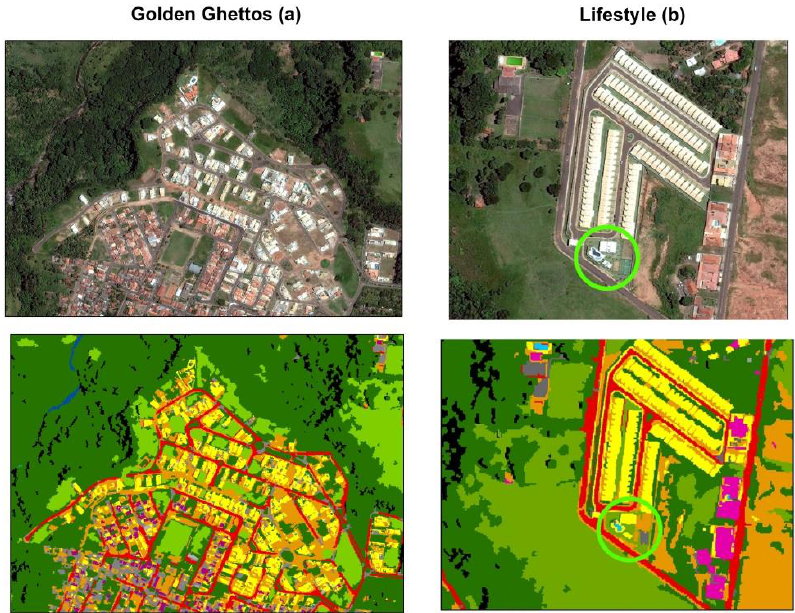
Figure 6. Map of the location and morphology of the control areas.